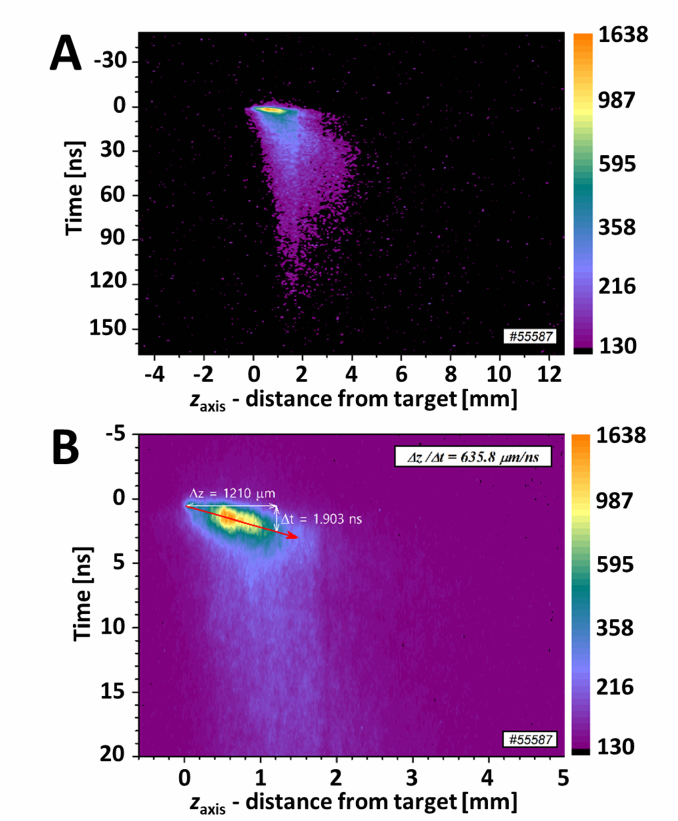
Figure 3. Spatial-temporal evolution of the plasma radiation obtained via streak camera ( panel A ), together with the depiction of the main longitudinal expansion direction (red vector, panel B